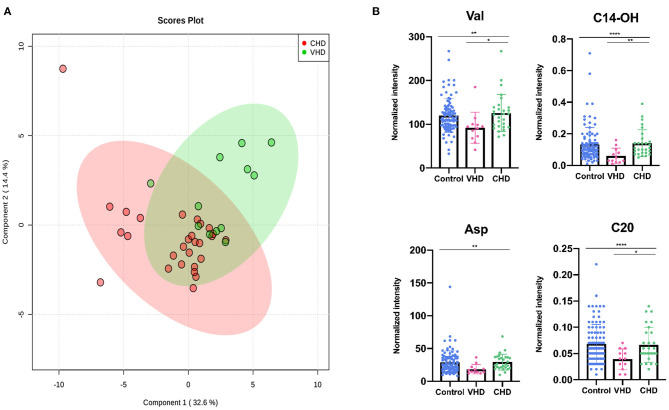
Diagnostic effectiveness of differential metabolites between HF patients and control group. (A) The receiver operating characteristic (ROC) curve of significantly changed metabolites (AUC > 0.8 were showed). (B) Correlation matrix of these differential metabolites. *p < 0.05; **p < 0.01; ***p < 0.001; ****p < 0.0001.